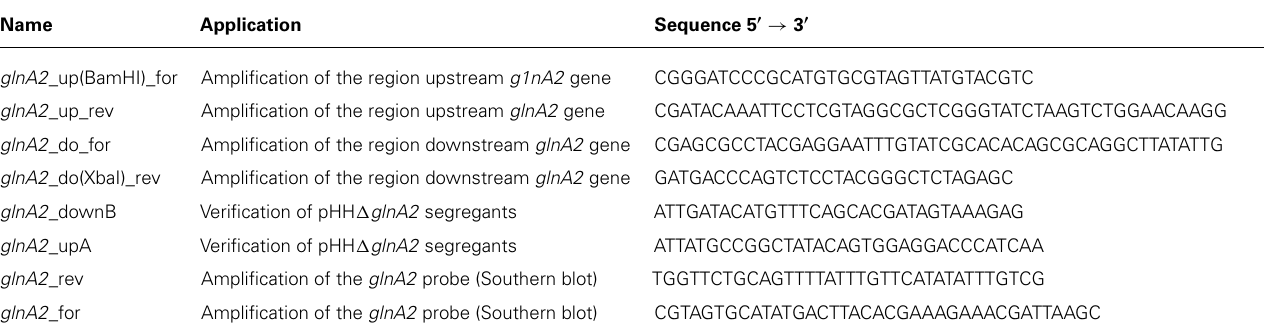
Table 2 | Oligonucleotides used in this study.